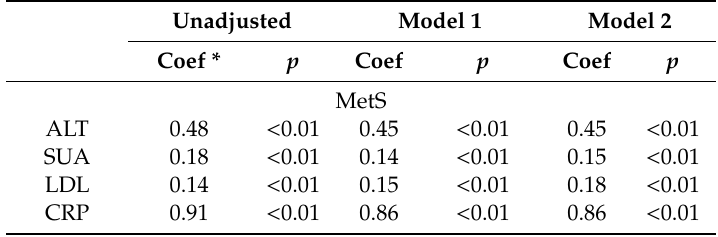
Table 4. Association between MetS and biochemical markers (in logarithm